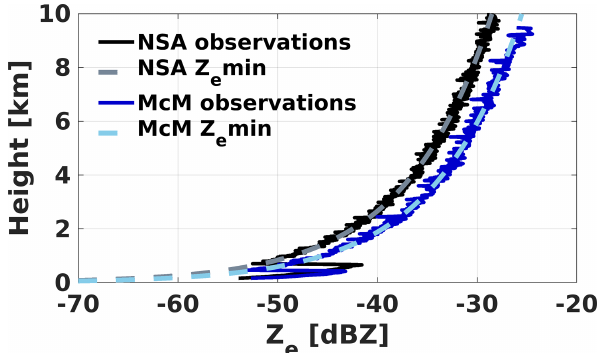
Figure A1. Minimum detectable KAZR Z e at the NSA and Mc- Murdo Station based on analysis of the full dataset discussed in Sect. 2. The smooth curves designate the theoretical minimum detectible Z e profile ( Z e ), using the KAZR Z e sensitivity at min 1kma.g.l.